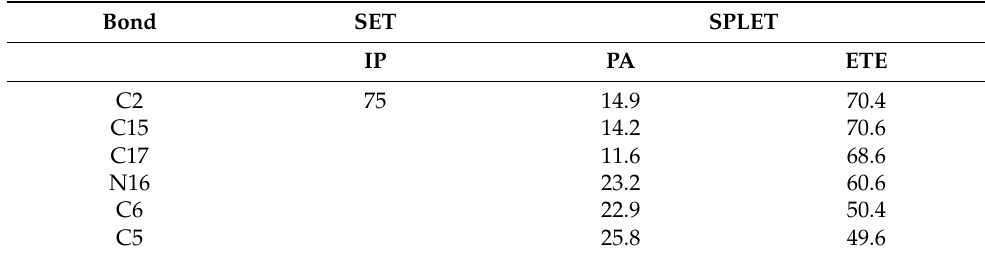
Table 2. Molecular descriptors of Bd: IP, PA, and